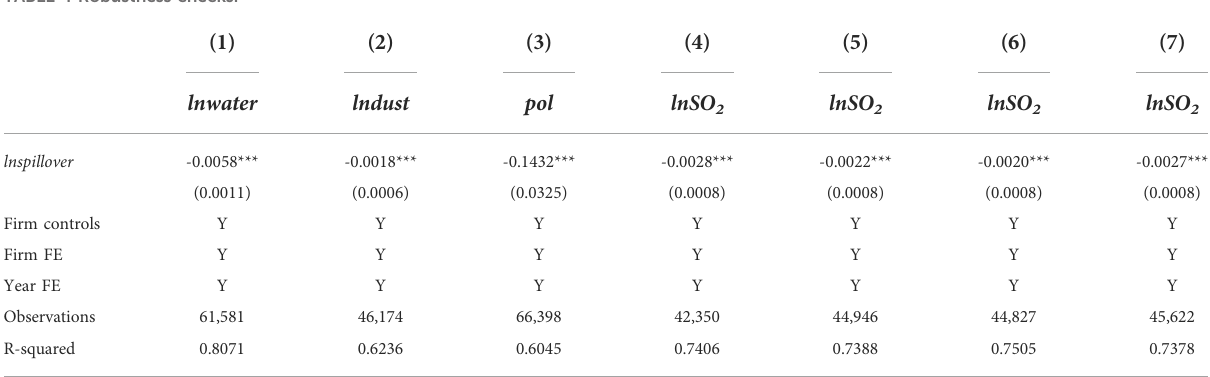
TABLE 4 Robustness